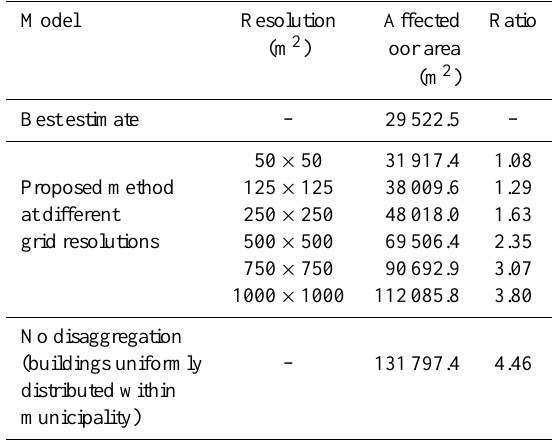
Table 6. Estimated flooded floor areas using different exposure